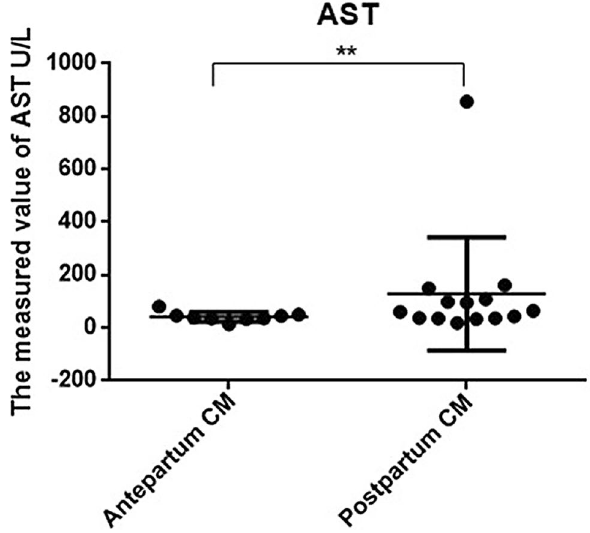
Figure 3. Comparison of liver function using AST between prepartum-diagnosed CM and postpartum- diagnosed CM.